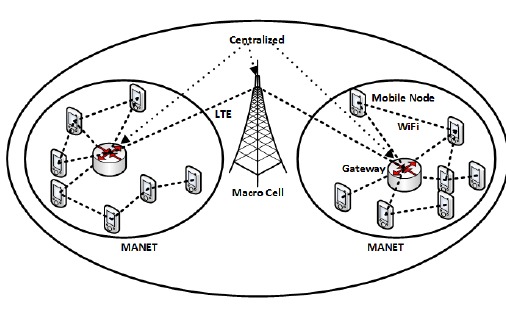
Figure 5. Cross-Domain